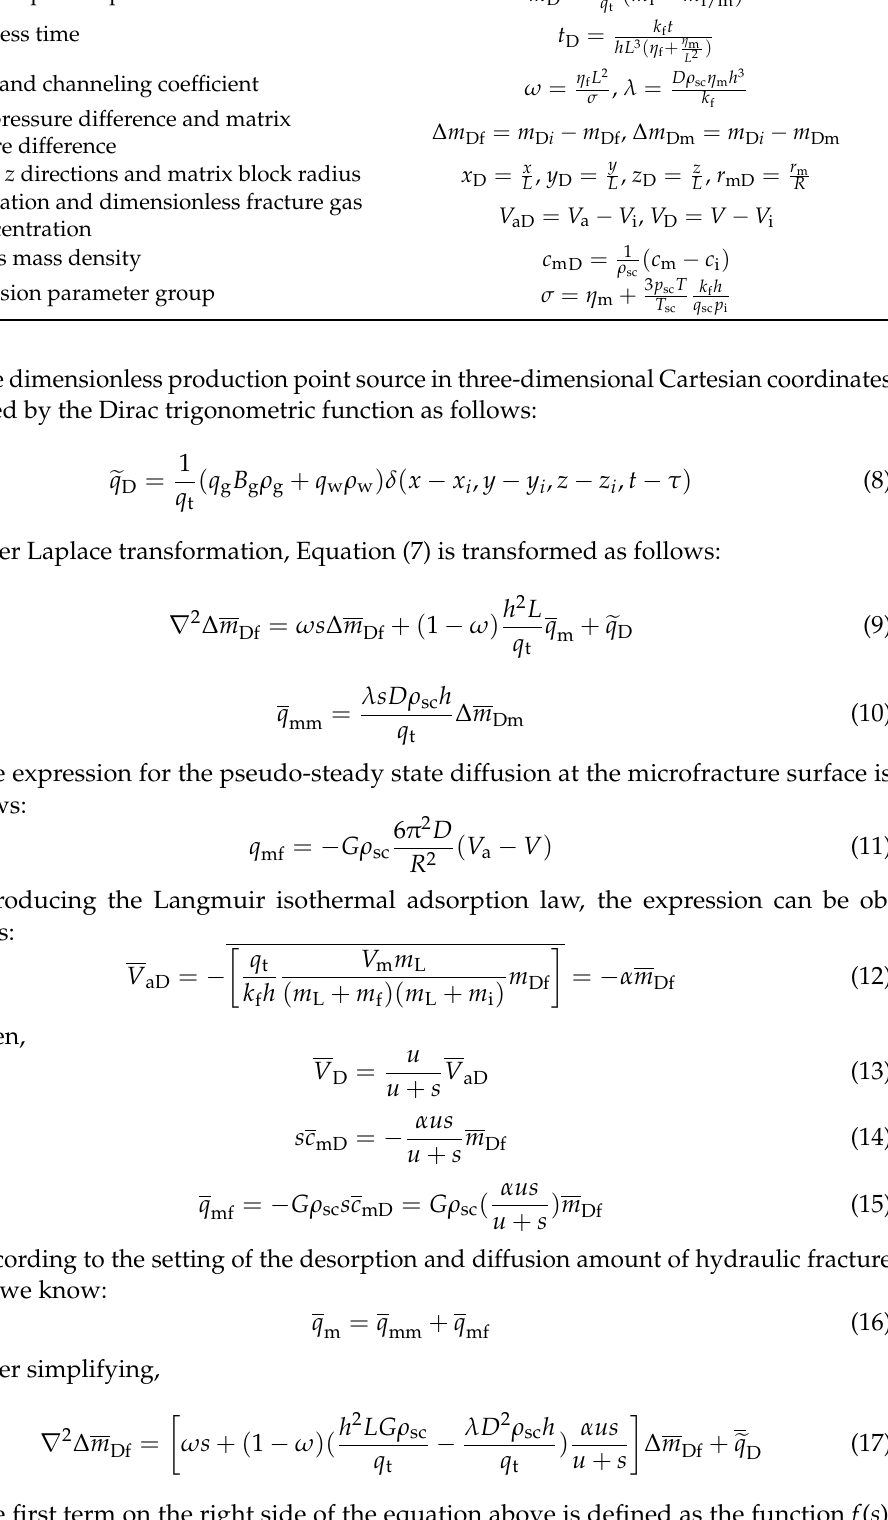
Table 1. Dimensionless parameters. Dimensionless Variable Dimensionless